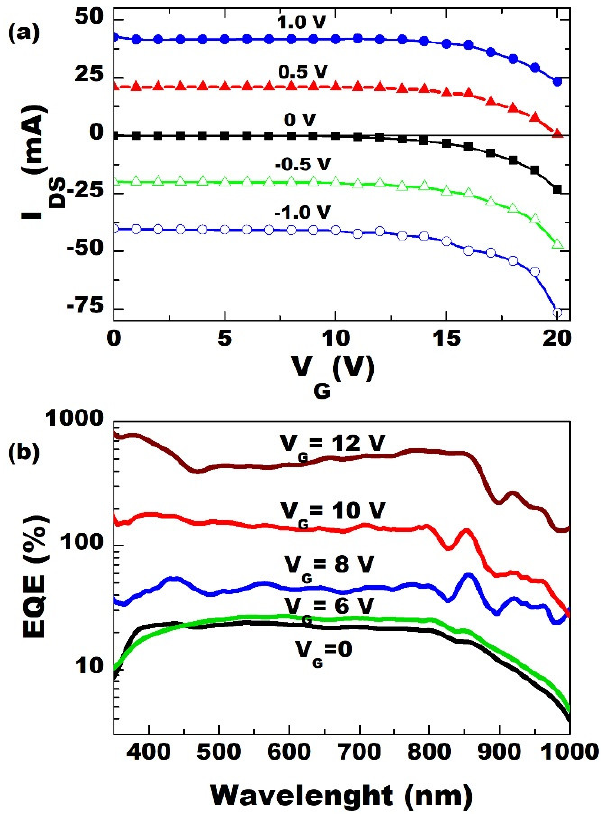
Figure 5. ( a ) Source-drain current I DS vs gate voltage V G acquired in dark conditions for different values of V DS ; ( b ) External quantum efficiency measured between S and D terminals as a function of the wavelength for different values of the gate voltage V G.